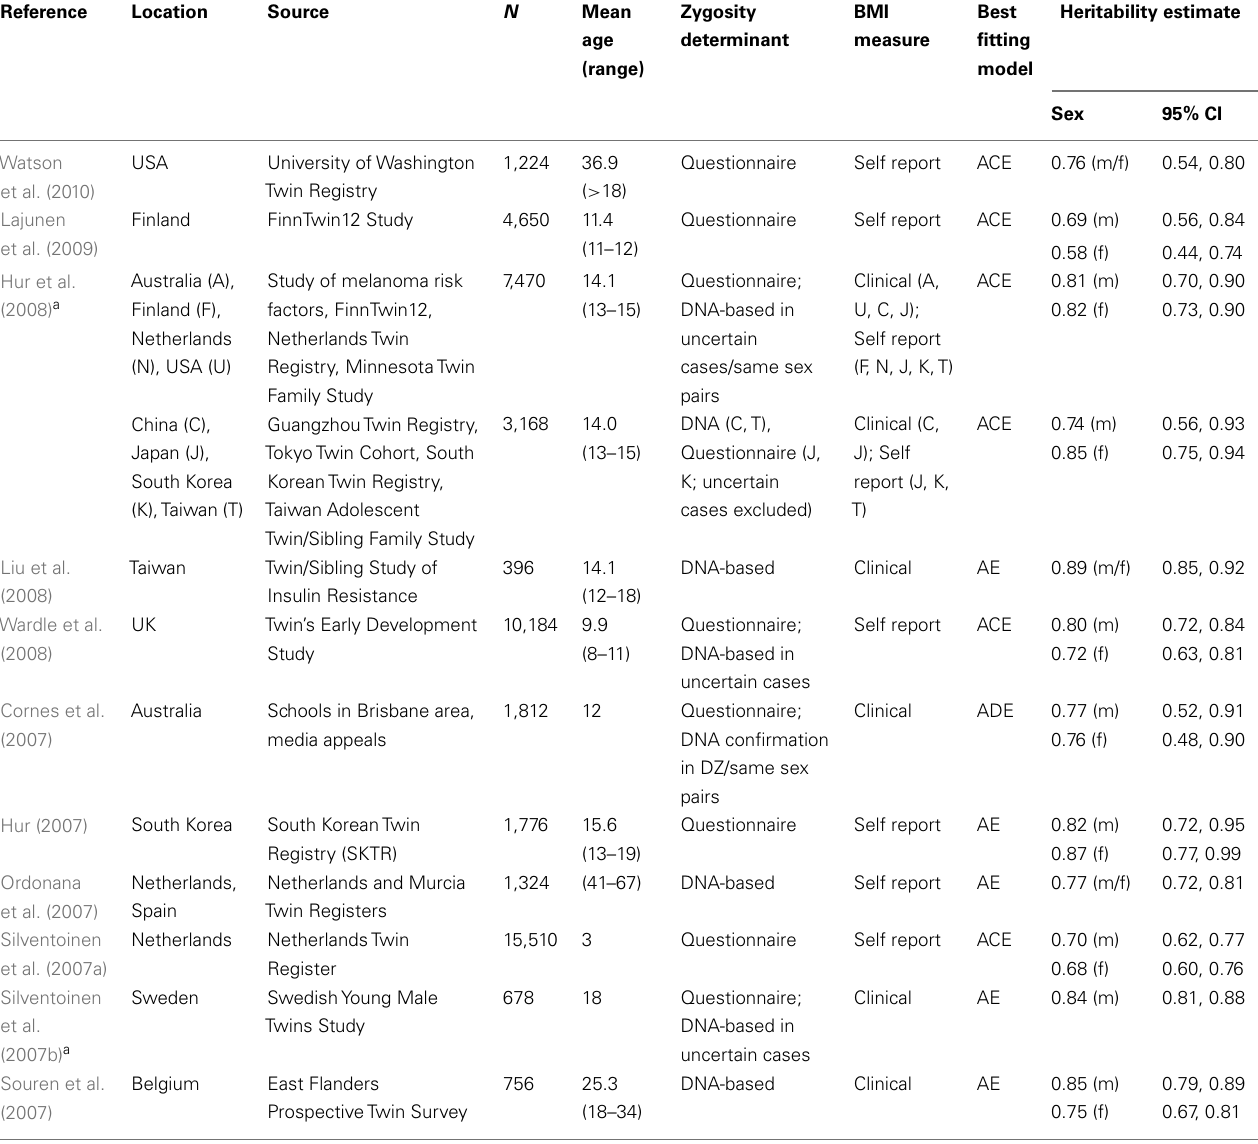
Table 1 | Details of the 31 papers reporting BMI heritability from twin